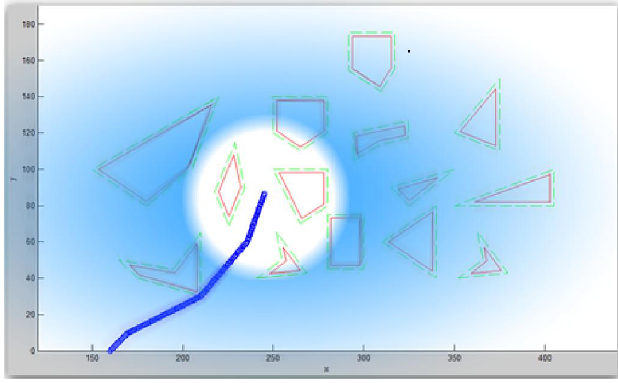
Fig. 6. The robot’s visual